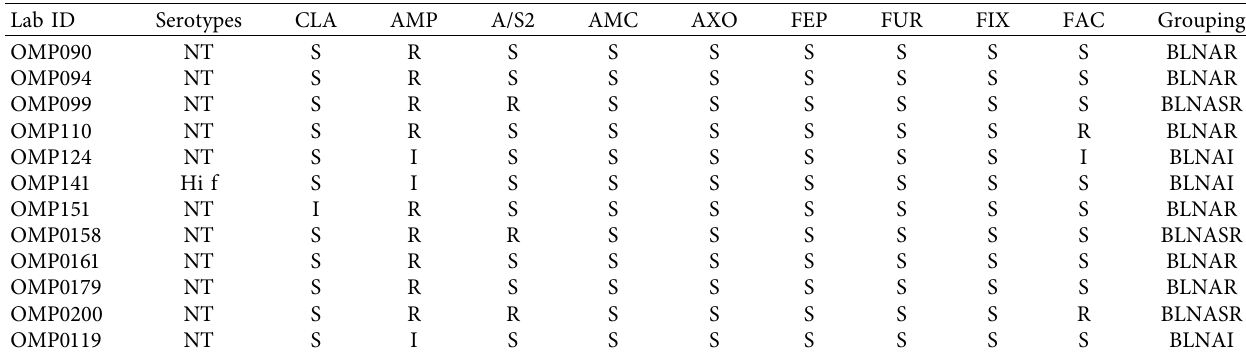
Table 3: Antibiogram of ampicillin nonsusceptible isolates of H . influenzae isolated from nasopharynx of school children with AOM. Lab ID Serotypes FUR FIX FAC